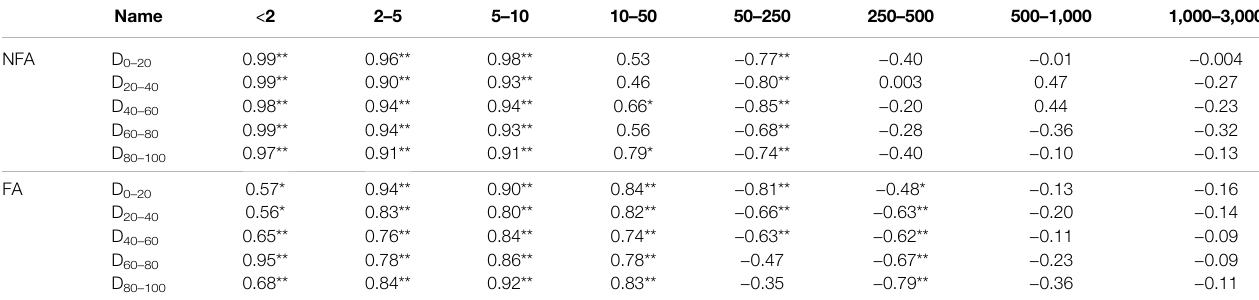
TABLE 3 | Correlation analysis between the soil particles and D in the woodland in the fl ooded area (FA) and the non fl ooded area (NFA).